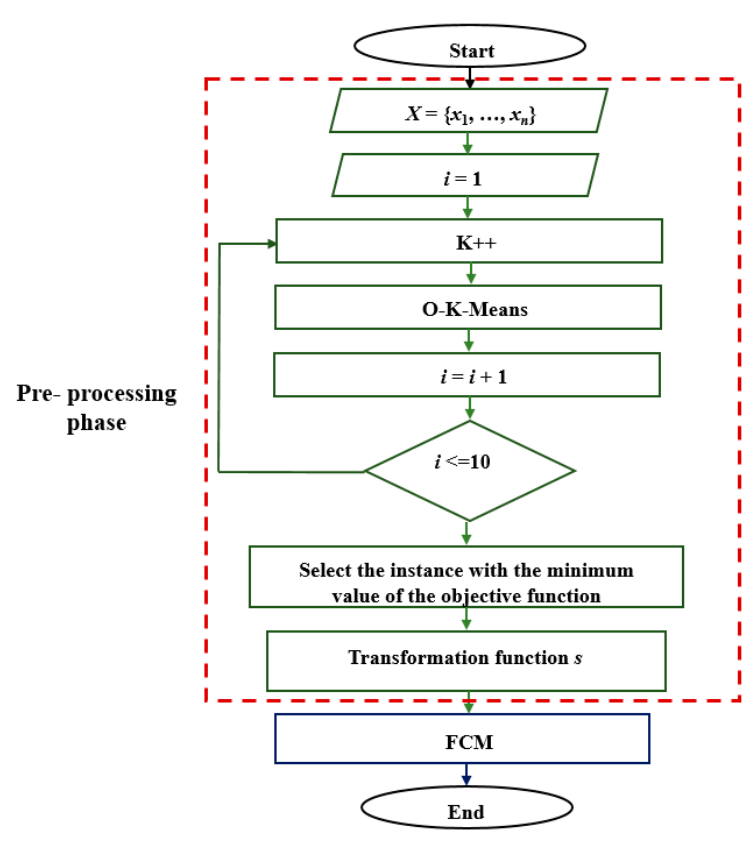
Figure 3. Structure of the HOFCM algorithm.